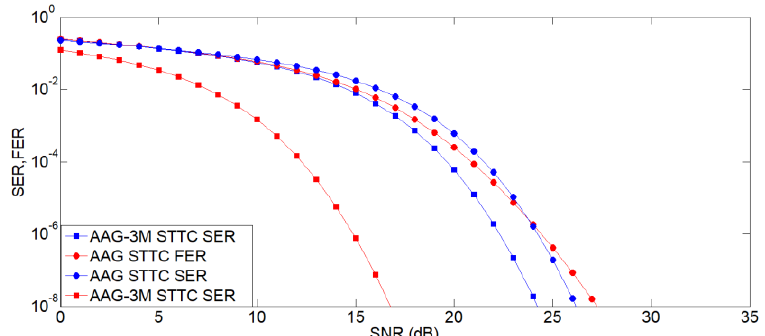
Figure 5. Comparison of Indoor hotspot and Ultra-Dense Urban deployment for AAG-3M STTC with Massive MIMO in terms of FER and SER.